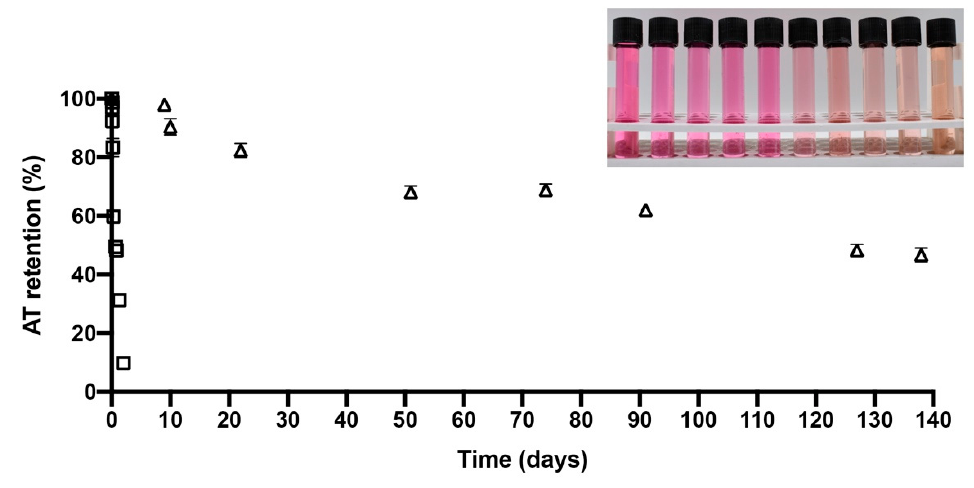
Figure 3. Evolution of anthocyanin retention from PPE and PPE-MD during storage at 60 °C. (PPE ( ) and PPE-MD ( Δ ). The photograph in Figure 3 shows the visual degradation of AT (evolution in color degradation) on analysis solution at during the time-course of the storage stability assay.